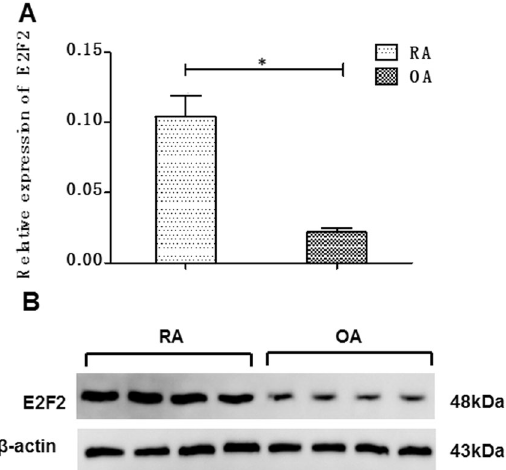
Figure 1. Expression of E2F2 in synovial tissues (STs). A , E2F2 mRNA expression in ST from patients with rheumatoid arthritis (RA; n = 10) and osteoarthritis (OA; n = 10) was determined by real-time PCR and calculated as 2 − ∆∆ Ct, with the GAPDH gene used as an endogenous control. B , Expression of the E2F2 protein in ST from RA(n = 10) and OA(n = 10) was evaluated by western blot analysis, with the β -actin protein used as a loading control. Values are expressed as mean ± SD of the mean and at least 3 independent experiments were performed; * p <